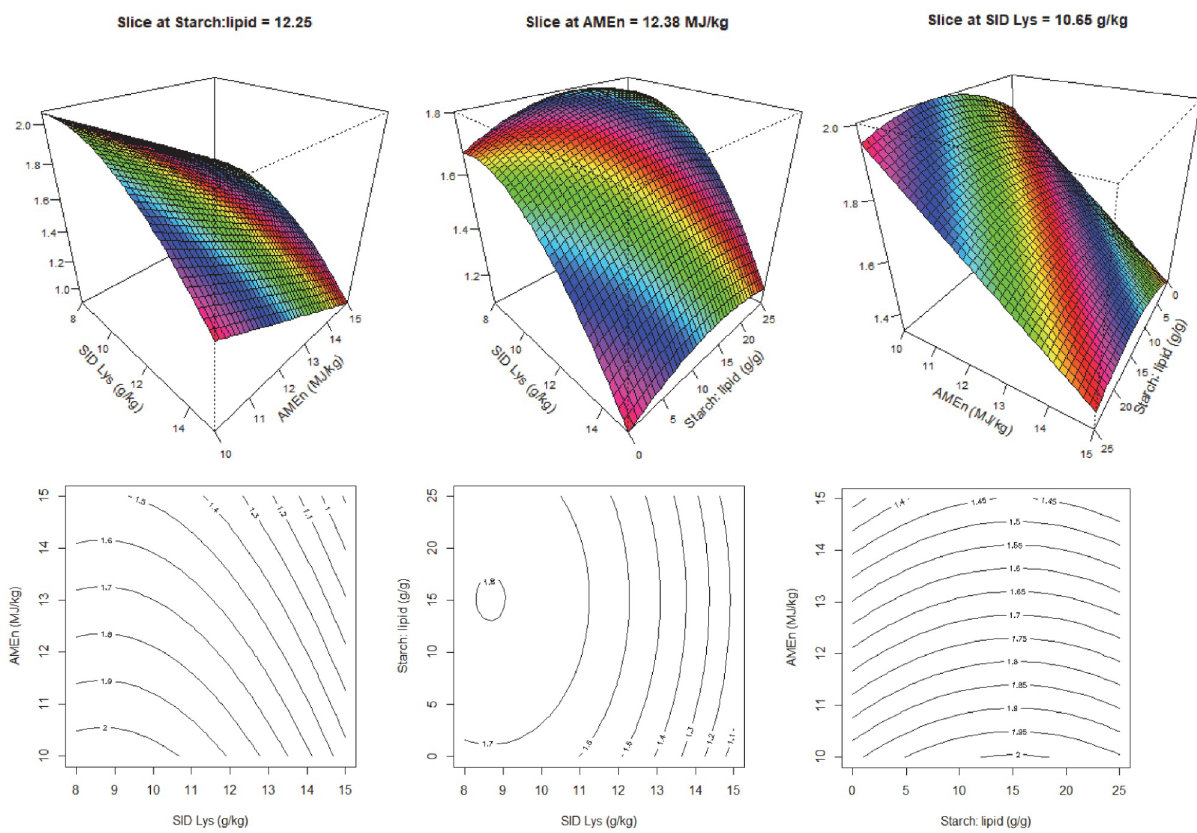
Fig 3. Response surface and contour plots describing relationships between FCR (g/g) and digestible lysine concentration (SID Lys), energy density (AMEn) and starch to lipid ratios (S:L) in broiler chickens from 21–35 days post-hatch.